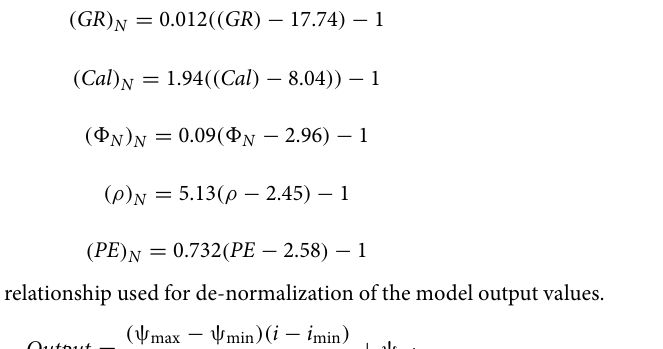
Table 2. The input parameters after normalization, are shown below from Eqs. (12)–(16).